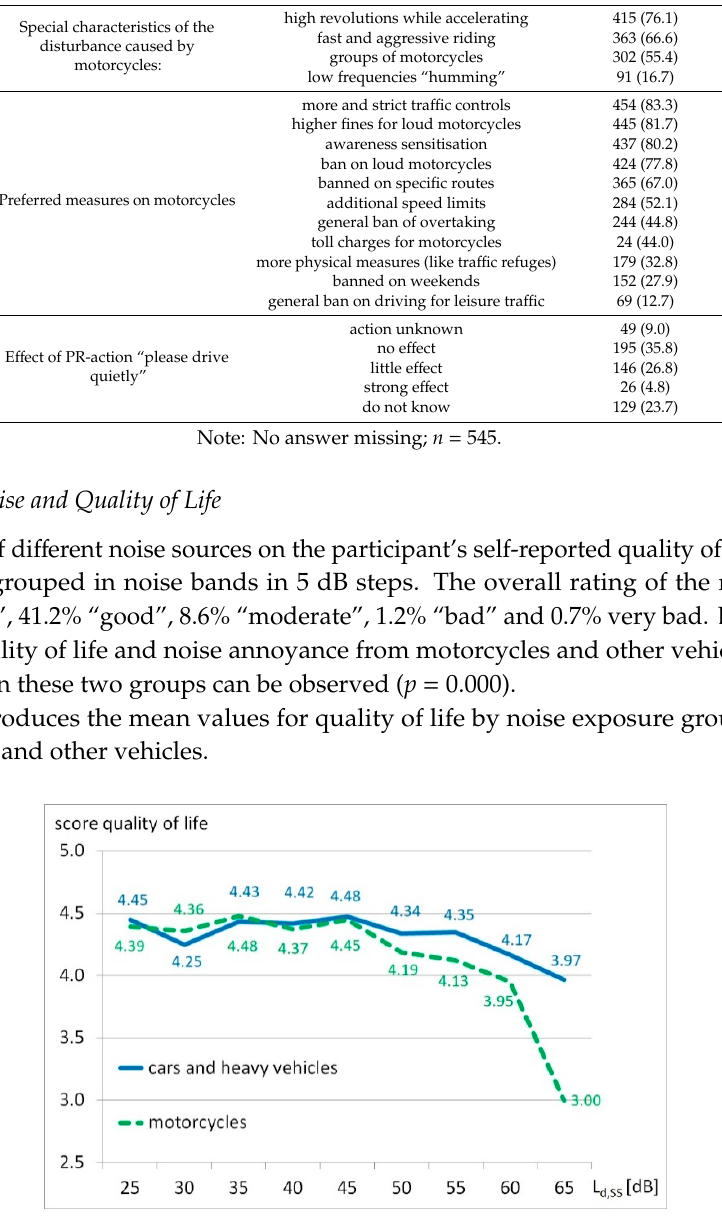
Figure 3. Mean values for quality of life by noise exposure groups expressed as equivalent continuous level during daytime on summer Sundays L d,SS in 5 dB steps from motorcycles and cars and heavy vehicles.